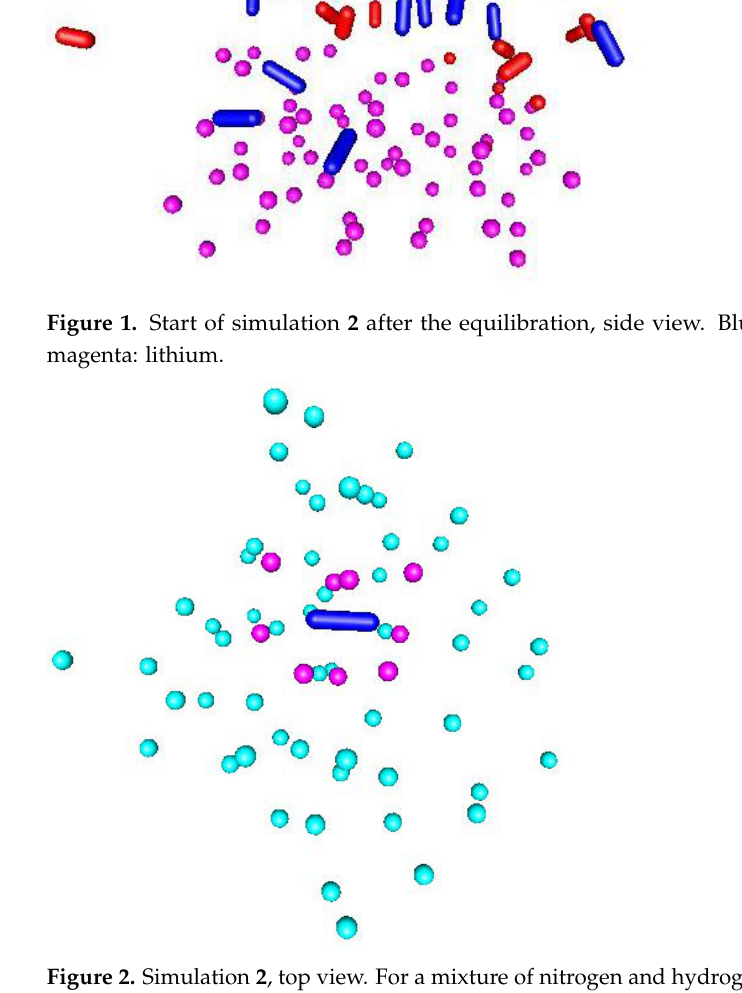
Figure 2. Simulation 2 , top view. For a mixture of nitrogen and hydrogen, a fast reaction of nitrogen with the lithium slab was observed. In the figure, only one nitrogen molecule is shown (blue), which is integrated into the bulk. All other nitrogen molecules and the hydrogen molecules are omitted in the graphical representation. The nearest neighbors of the N 2 moiety are highlighted in magenta; all other lithium atoms are